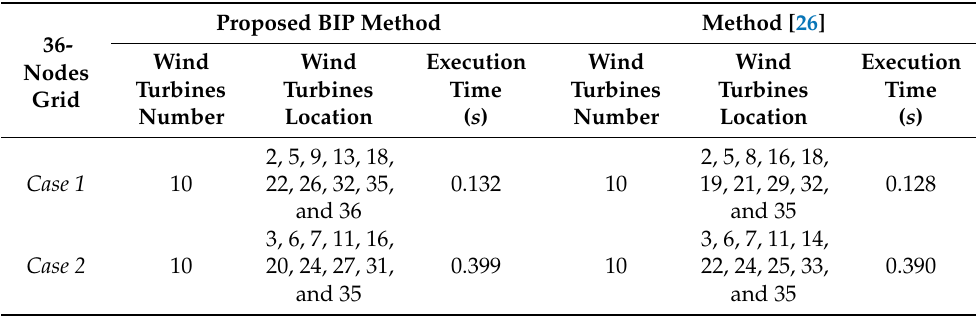
Table 2. Comparison of the proposed BIP method with work [26].